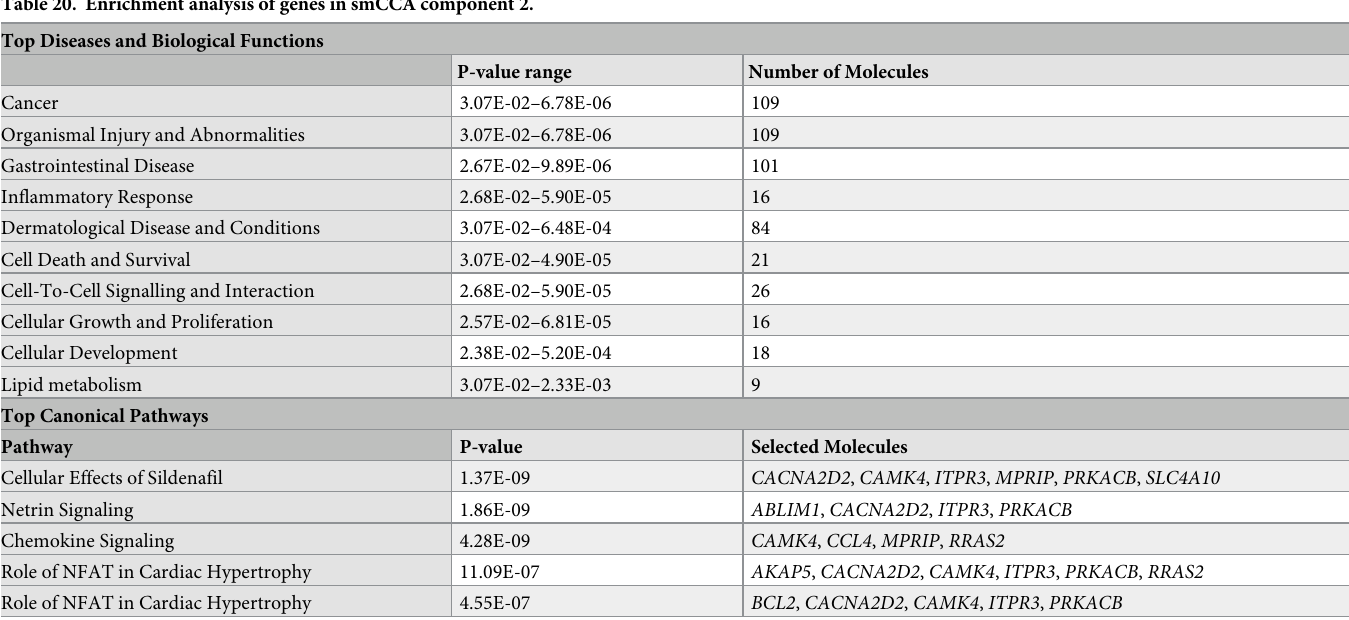
Table 20. Enrichment analysis of genes in smCCA component